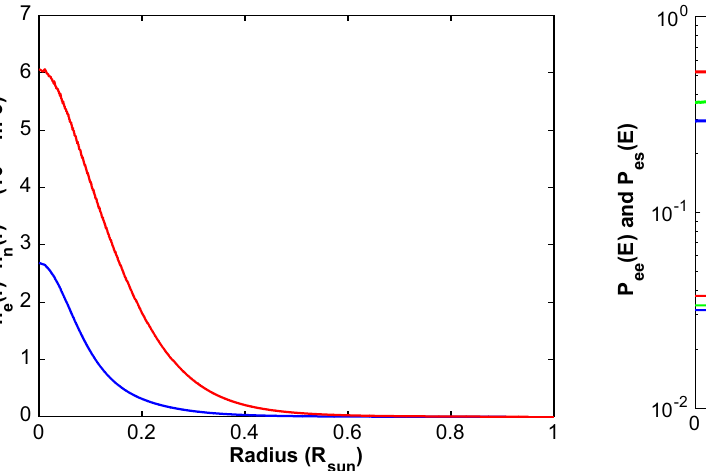
Fig. 1 The plasma of the Sun’s core is made of ions and free elec- trons. The plot shows the variation of the number density of electrons n e ( r ) (red curve) and neutrons n n ( r ) (blue curve). In the computation of this quantities we used the solar standard model which is in excel- lent agreement with the helioseismic data. See Lopes and Silk [30] for details